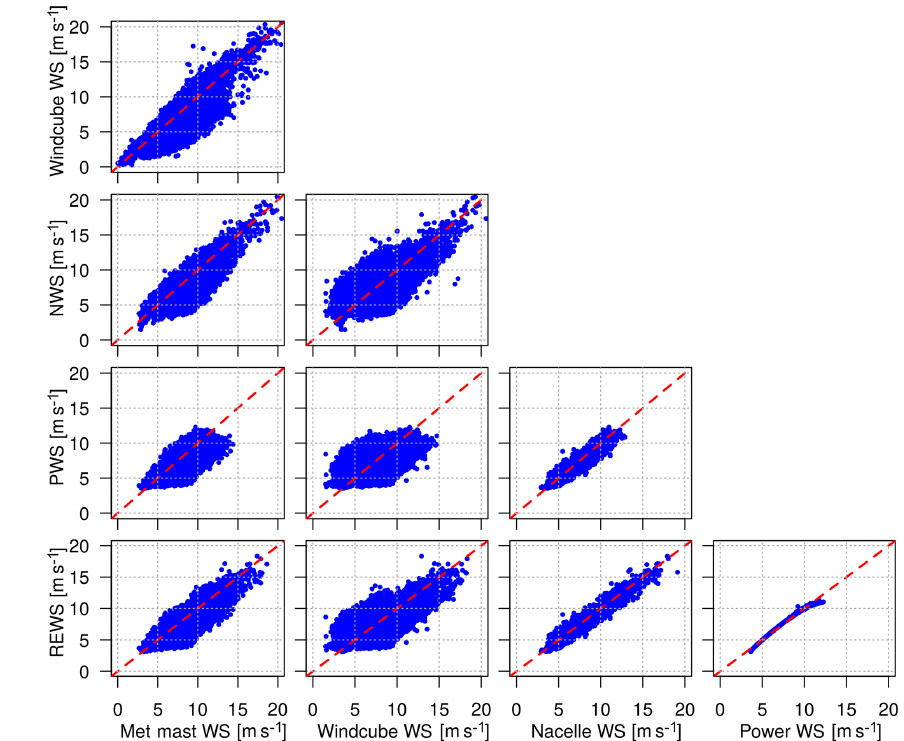
Figure 3. Comparison of wind speed measurements at SMV5 (for nacelle wind speed, power wind speed and rotor effective wind speed) and at external sensors (met mast and Windcube). No sector filtering was applied to the data, explaining the scatter when comparing sensors at different locations.